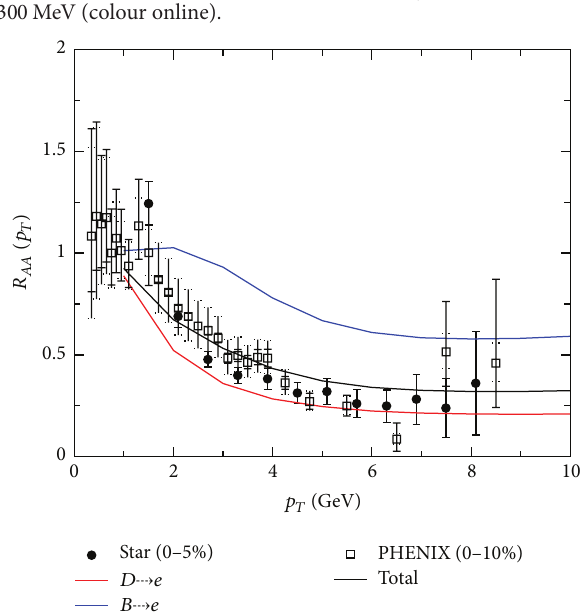
Figure 9: Variation of 𝑅 𝐴𝐴 with 𝑝 𝑇 for 𝑐 2 𝑠 = 1/5 and 𝑇 𝑖 = 210 MeV (colour online).